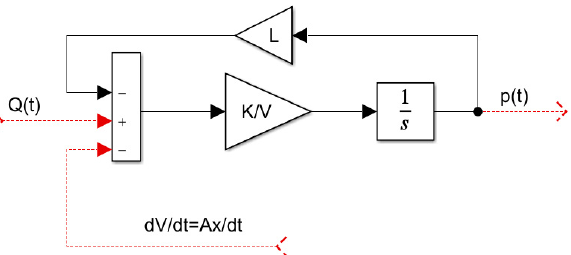
Figure 11. Block diagram of the hydraulic part of the hydraulic motor. Red lines are Input/Output (I/O) signals in this part of the block diagram.